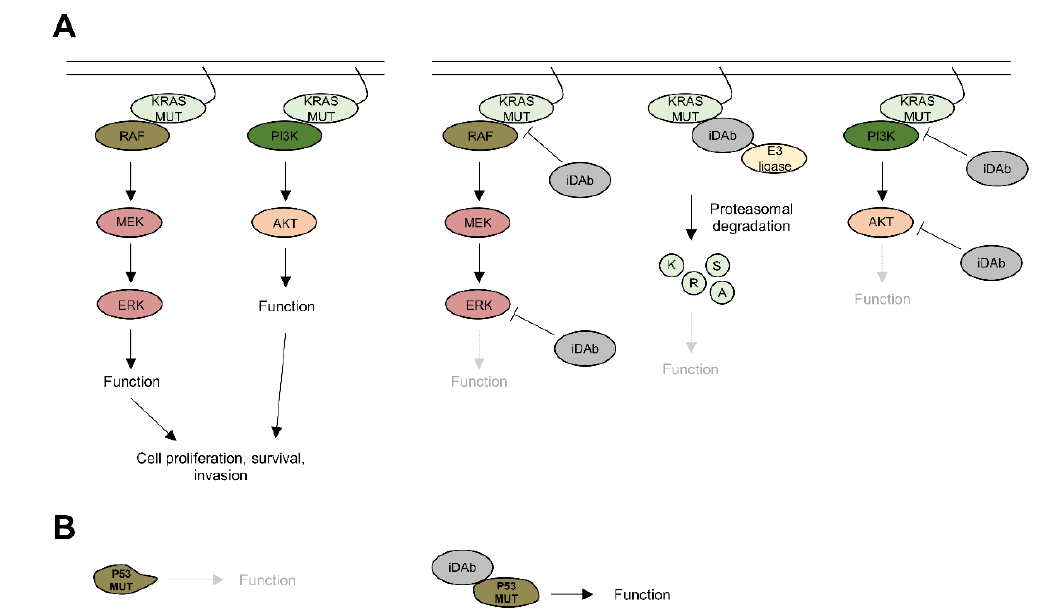
Figure 4. Potential of intracellular antibodies in pancreatic cancer. ( A ) Intracellular antibodies can be used to block protein–protein interactions between KRAS and its effectors, RAF or PI3K, to di- rectly degrade KRAS by targeted protein degradation or to block downstream signalling kinases, such as ERK and AKT, to inhibit cell proliferation, survival or invasion. ( B ) Intracellular antibodies could be employed to restore the function of tumour suppressors, such as P53, by modifying their conformation.